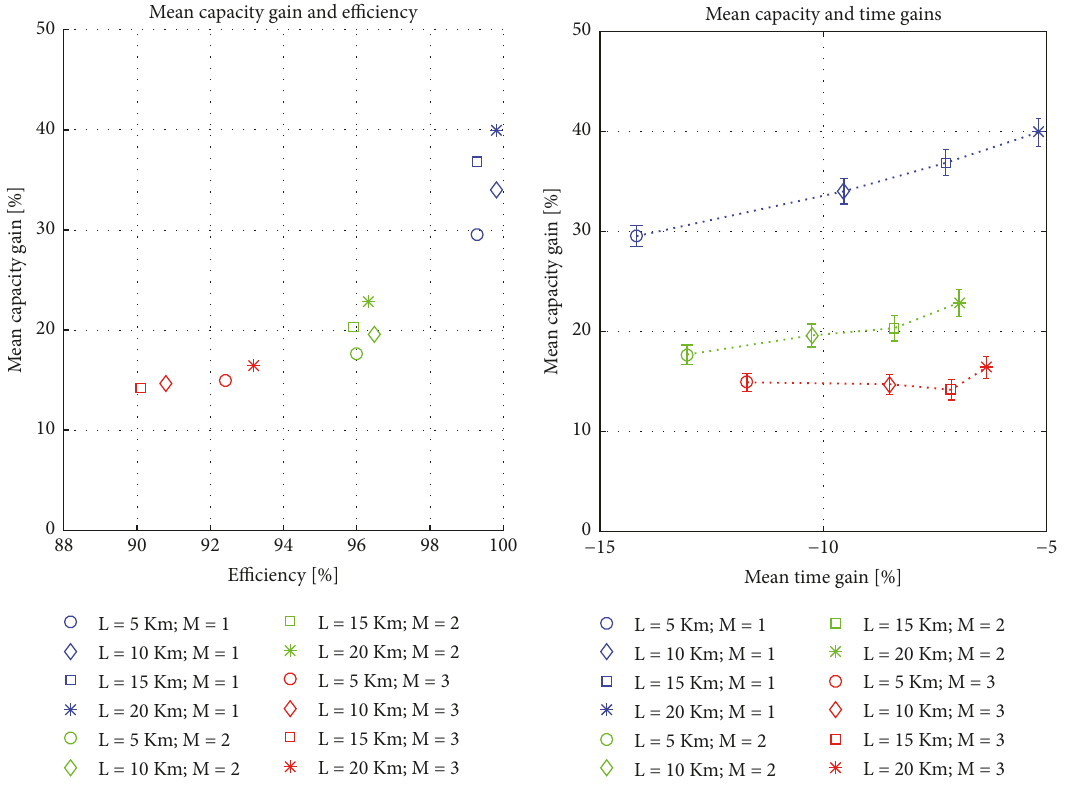
Figure 3: Mean capacity gain as a function of the efficiency (left) and mean time gain (right).